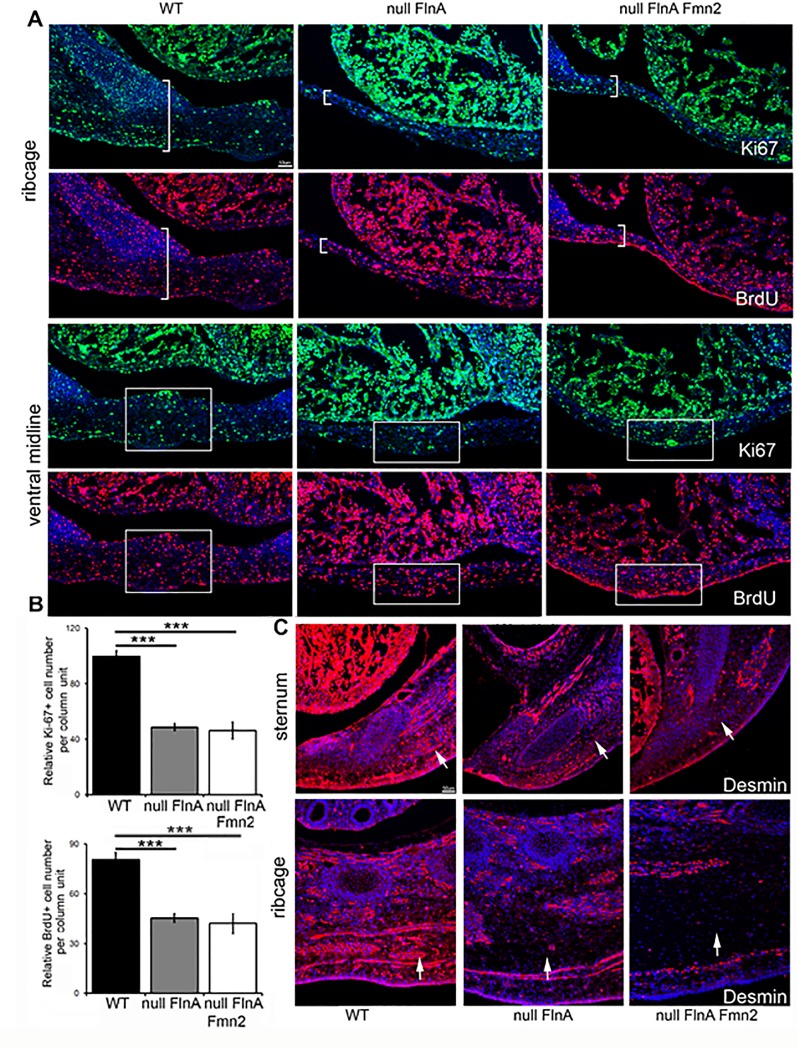
Loss of FlnA and Fmn2 leads to a defect in cell proliferation along the ventral thoracic wall.A. Fluorescent photomicrographs of immunostaining performed on transverse sections of E13.5 mouse thorax for proliferation markers. Ki-67 (a marker for cells in the cell cycle) and BrdU (a marker labeling cells entering into S phase) revealed a significant decrease in the number of proliferating (Ki-67+ or BrdU+) cells per unit area in the ribcage and ventral midline of the null FlnA and null FlnA+Fmn2 embryos compared to control WT embryo. Brackets mark the thickness of the ribcage, whereas the rectangular box delineates the thickness of the ventral midline. B. The number of BrdU or Ki67 positive cells in the ventral midline of null FlnA and null FlnA+Fmn2 embryos was decreased by more than 50% in comparison with those in WT embryo (WT vs null FlnA *** = p <0.0002, WT vs null FlnA+Fmn2 *** = p <0.0008). C. Immunostaining of E13.5 mouse ribcage and sternum for desmin, a mesenchymal and muscle cell marker reveals a reduction in the numbers of mesenchymal-derived cells in null FlnA and null FlnA+Fmn2 embryos (arrows). Nuclei are counterstained with DAPI (blue color) in all the images. Three homotopic sections were examined from n>3 littermate mice per experimental variable. Scale bars = 50 μm.